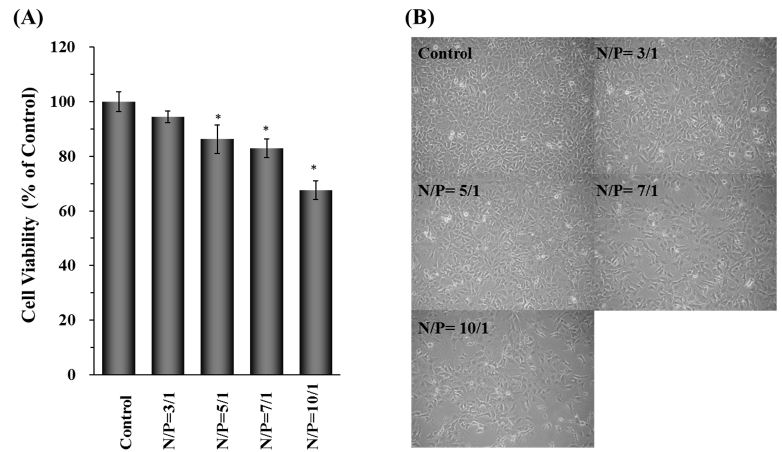
Figure 4. Cell viabilities ( A ) and cell morphological changes ( B ) of Hep 3B cells after incubated with DDNPs which were prepared with various N/P ratios. The control group denotes the group of cells without any treatment. * p < 0.05, significant difference between the group with various N/P ratio and the control group as analyzed by Student’s t test.